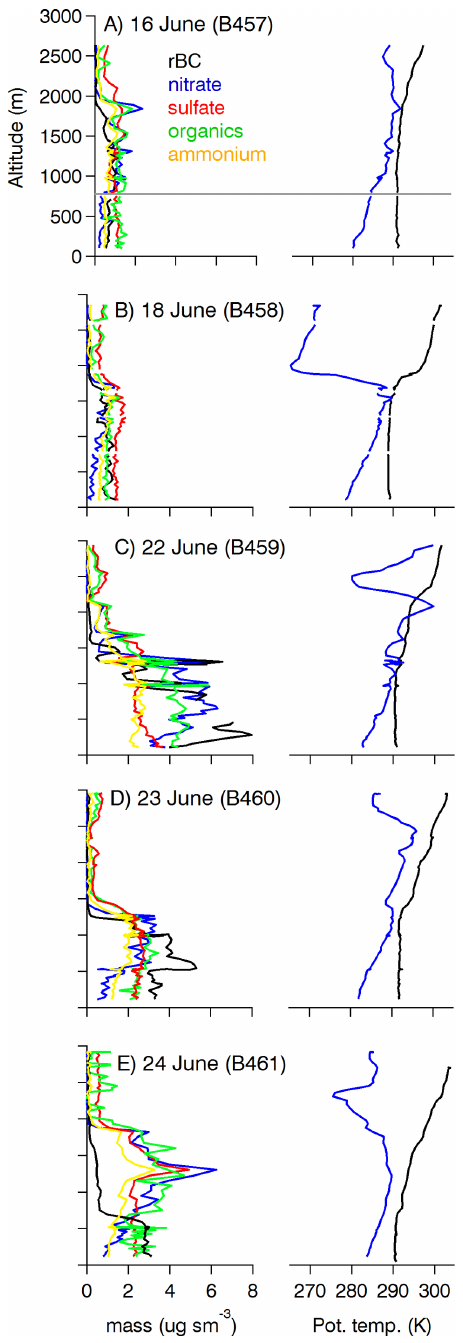
Fig. 12. Altitude profiles in the vicinity of Northolt airfield (Fig. 1) for (left) sub-micron aerosol mass concentrations over London and (right) potential temperature (black) and potential dew point tem- perature (blue). Refractory black carbon (rBC) was measured by the SP2 and organics, nitrate, sulphate and ammonium were measured by the AMS. rBC mass concentrations were multiplied by five to appear on the same scale as the AMS species. The horizontal grey line shows the altitude of the around London circuits. All axes are to identical